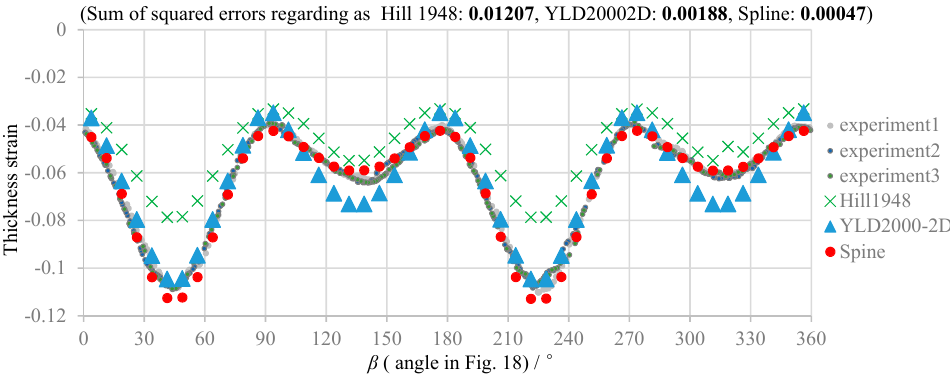
Figure 26. Comparison of thickness strain distributions on circle 1 in experimental condition E.